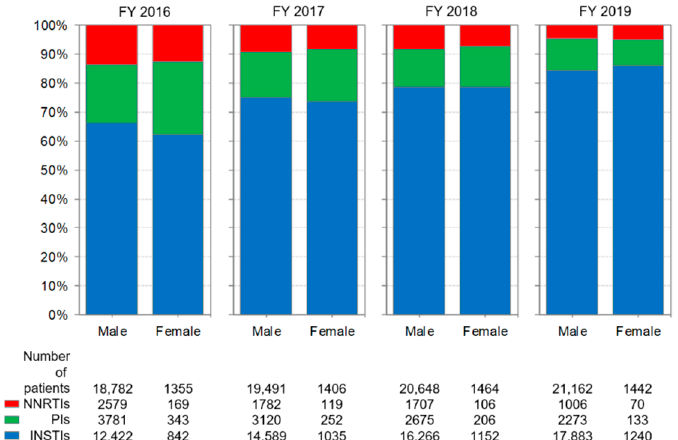
Figure 7. Changes in the prescriptions of anchor drugs by sex. The analysis was performed on drugs listed in Table 1. NNRTI: non-nucleoside reverse transcriptase inhibitor, PI: protease inhibitor, INSTI: integrase strand transfer inhibitor.